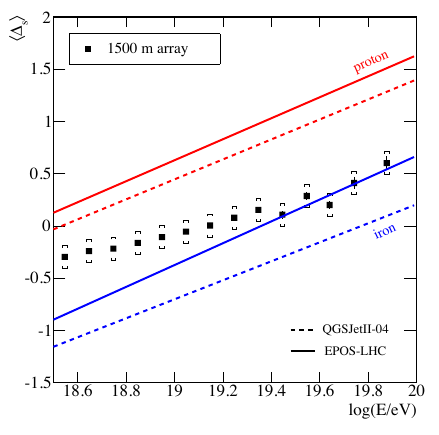
∆ s method analysis (cid:31) (cid:30)